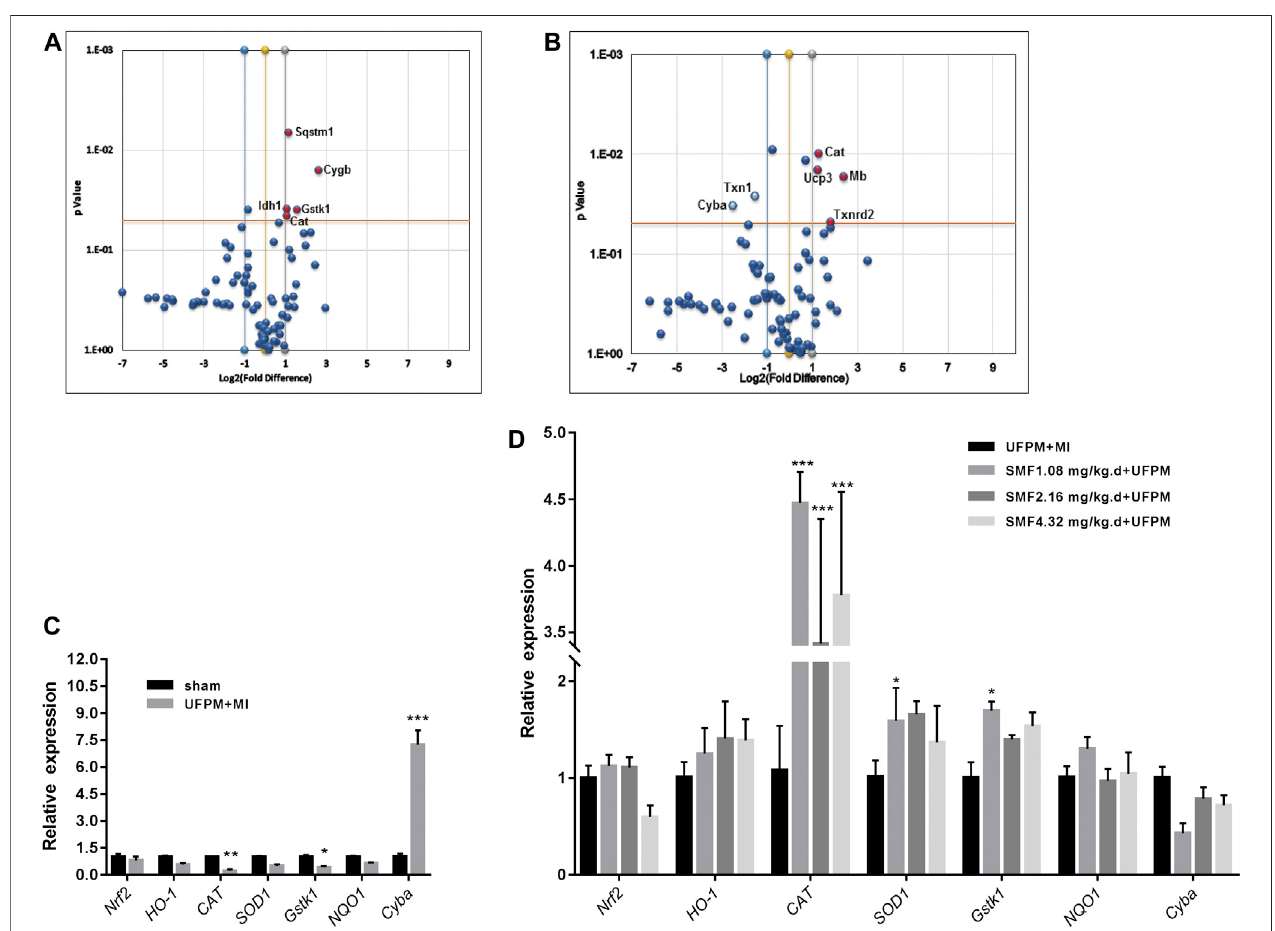
FIGURE6| RT 2 Pro fi lerPCRarrayanalysisofoxidativestress-relatedgeneexpressioninthemyocardialtissuesofrats. (A) Ascatterplotcomparingtheexpression of 84 oxidative stress genes from rats exposed to UFPM gene expression in the sham controls. (B) A comparison of geneexpression in rats pretreated with SMF before UFPM exposure to UFPM-exposed rats. Red solid circles identify genes with at least a 2-fold decrease (A) or a 2-fold increase (B) in expression. The central line represents unchanged gene expression and the boundaries represent the 2-fold cut-off value for changes in expression. (C,D) qRT-PCR validation of some oxidativestressgenes.Thehistogramrepresentsfold-changesingenesup-ordownregulatedintheUFPMgroupcomparedtotheshamandSMFgroupscomparedto the UFPM group.